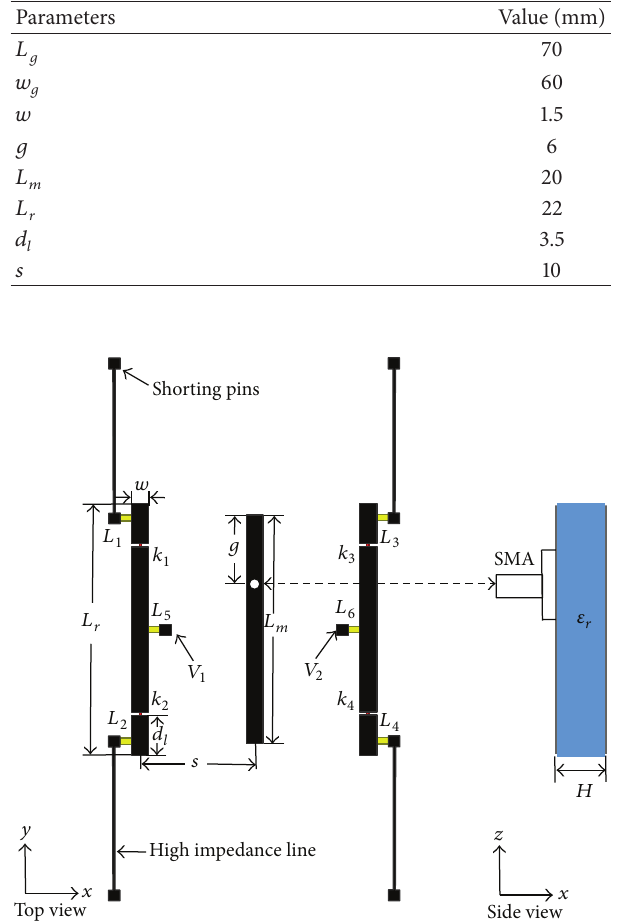
Figure 2: Geometry of the pattern reconfigurable